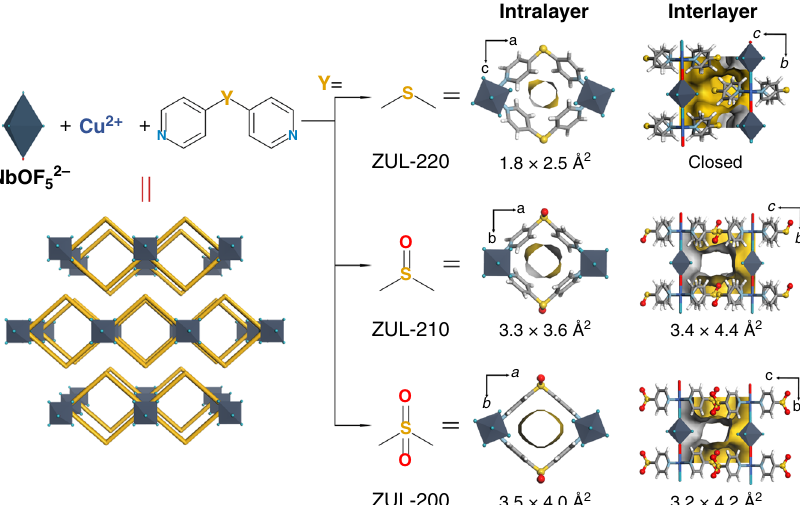
Fig. 1 Crystal structures. X-ray crystal structures of activated ZUL-220, ZUL-210, and ZUL-200 (Color code: F, teal; Nb, plain blue; C, gray; H, white; N, sky blue; S, yellow; O, red; Cu,